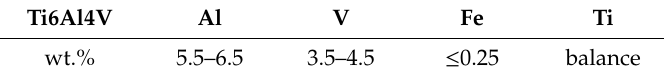
Figure 3. Sketch of the electrophoretic deposition process. Table 1. Chemical composition of the Ti6Al4V alloy substrate.